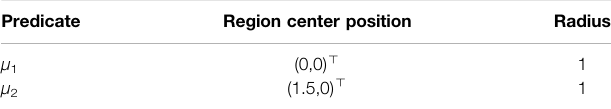
Frontiers in Robotics and AI |